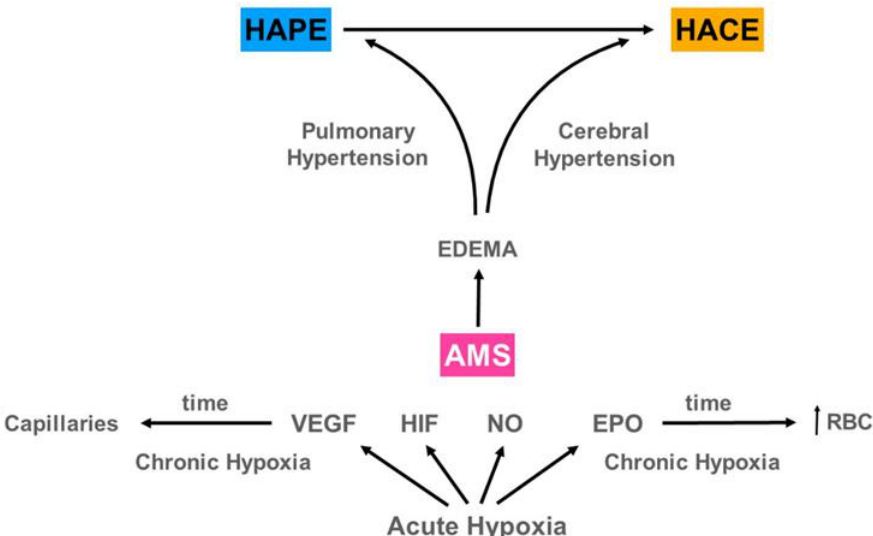
Figure 5. We postulate that AMS on exposure to high-altitude hypoxia can sometimes evolve to either High Altitude Pulmonary Edema (HAPE) and/or High Altitude Cerebral Edema (HACE). After recovery or if there is no altitude illness, the evolution towards an increase of hemoglobin, hematocrit, and red blood cells and the formation of more capillaries makes the organism of high-altitude residents resistant to several diseases and can even lead to extended longevity. VEGF = Vascular Endothelial Growth Factor, HIF = Hypoxia Inducing Factor, NO = Nitric Oxide, EPO = Erythropoietin, RBC = Red Blood Cells.